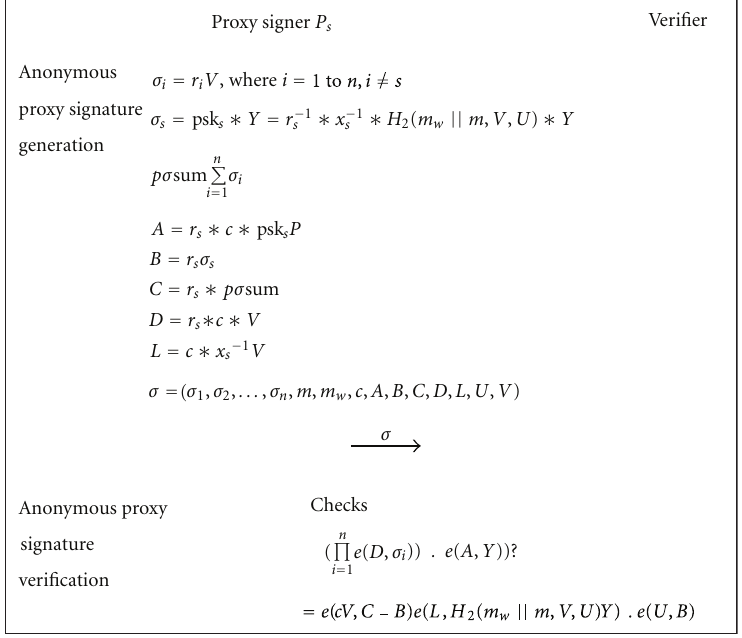
Figure 4: Anonymous proxy signature generation phase and the verification phase of our